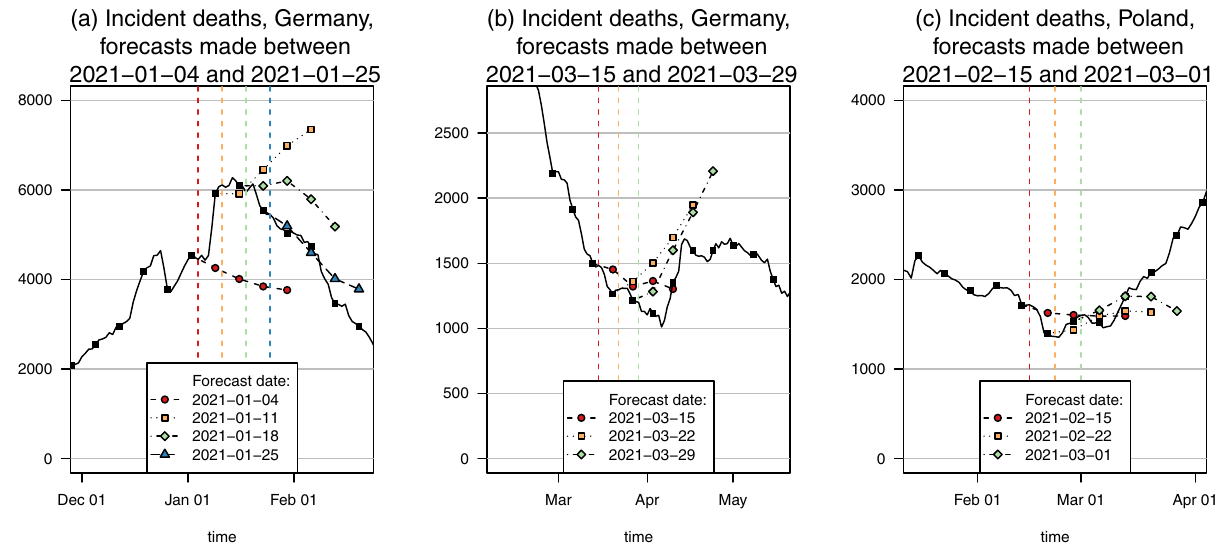
Fig. 7 Death forecasts preceding trend changes. Point forecasts of the median ensemble during changing trends in deaths. a Downward turn in Germany, January 2021. b Upward turn in Germany, March 2021. c Upward turn in Poland, February/March 2021. Different colors and point/line shapes represent forecasts made at distinct time points (marked by dashed vertical